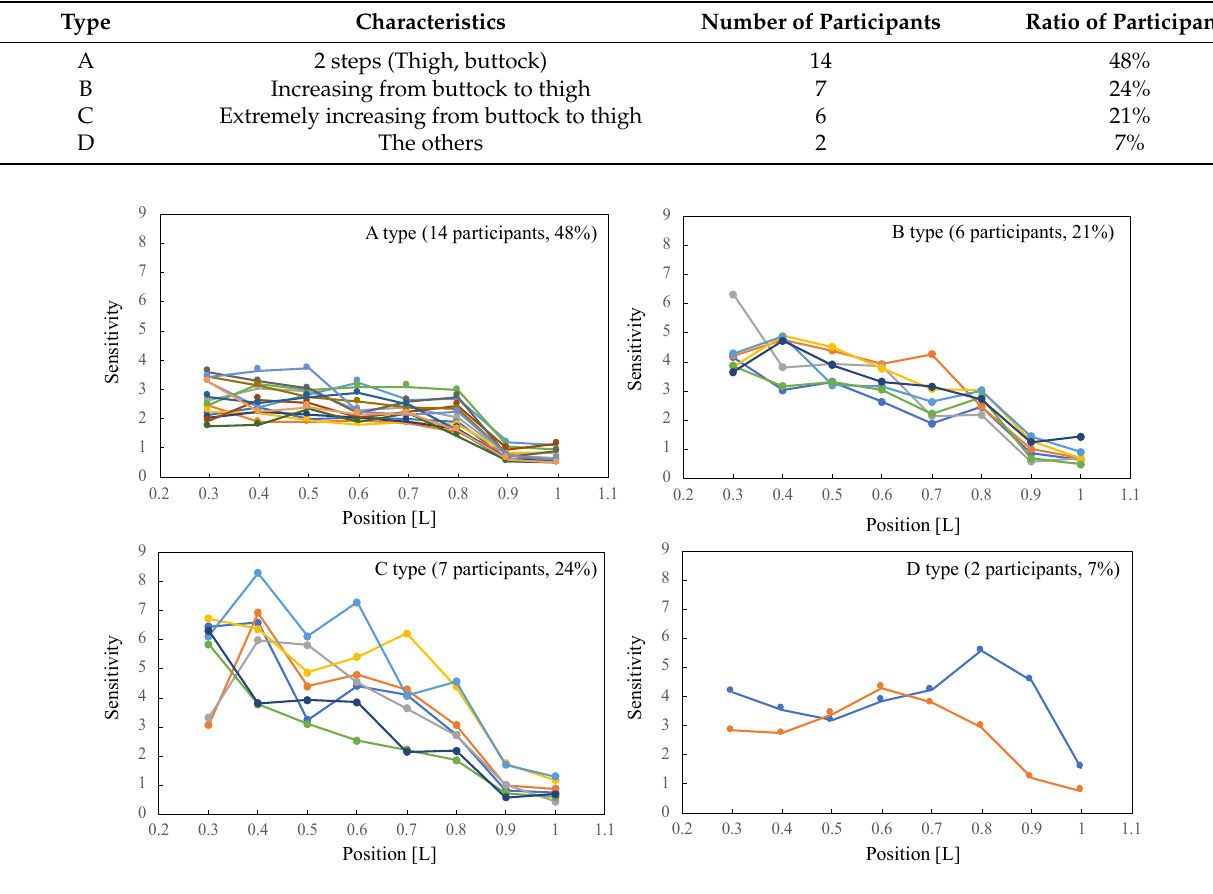
Figure 8. Four types of measured sensitivity.